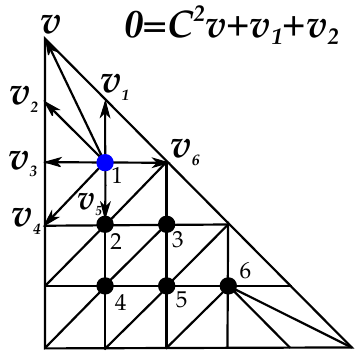
Figure 1 . An example of a toric Calabi-Yau threefold singularity and its crepant resolution. Each toric divisor is presented as a point on the ( x; y )-plane, and we label their coordinates in Z 3 . Each 2d cone is presented as a line segment between the points and each 3d cone is given by a polygon. On the left hand side, there is a singular toric Calabi-Yau threefold with four non-compact divisors D 1 ; : : : ; D 4 . On the right hand side, after the crepant resolution, the toric fan is subdivided and each 3d cone (presented as a triangle) has unit volume. There is a new compact divisor S 1 in the middle.